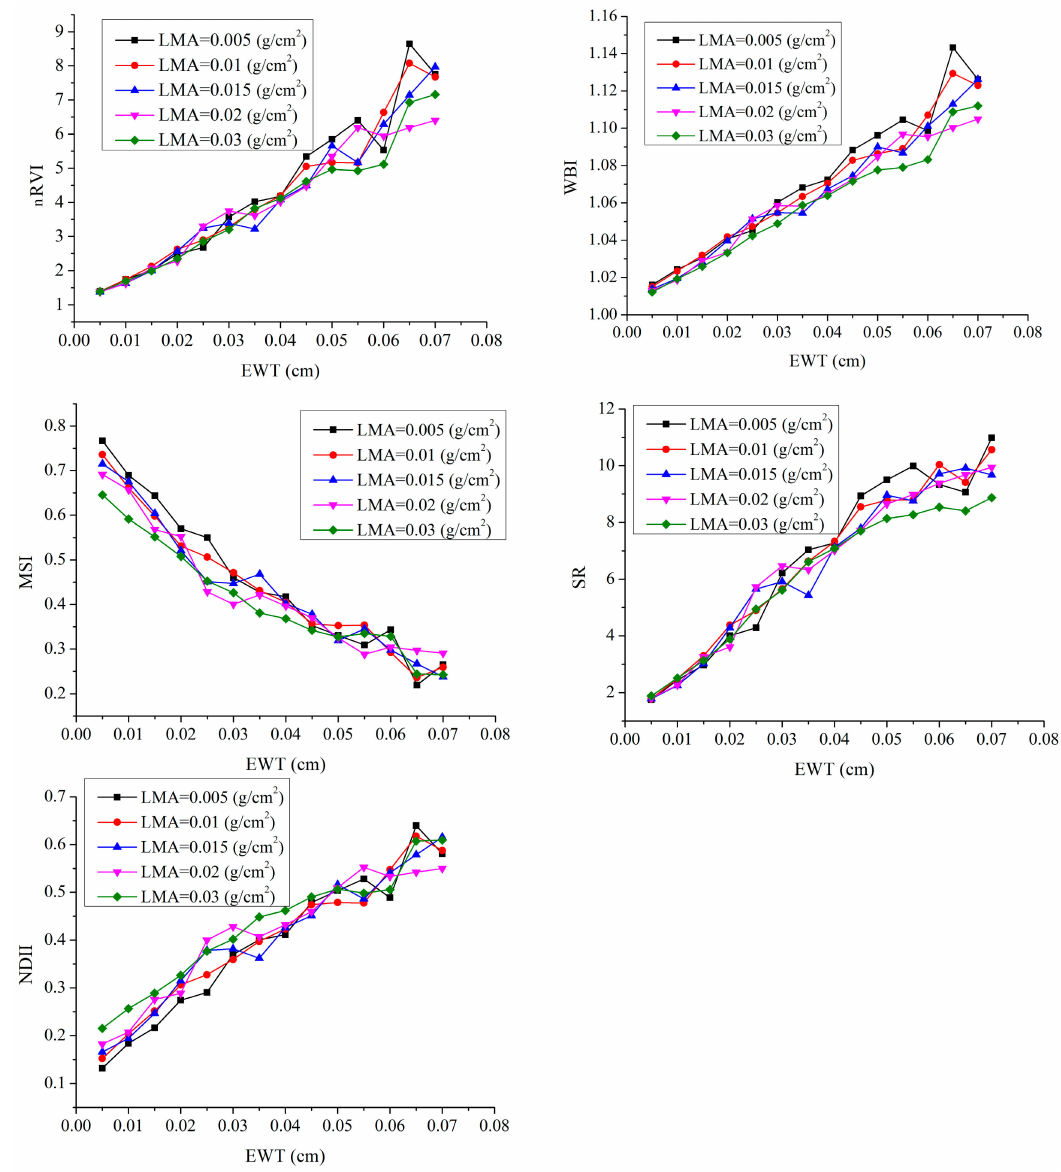
Figure 8. Robustness of nRVI, WBI, MSI, SR, and NDII to variations in LMA across various EWT values.